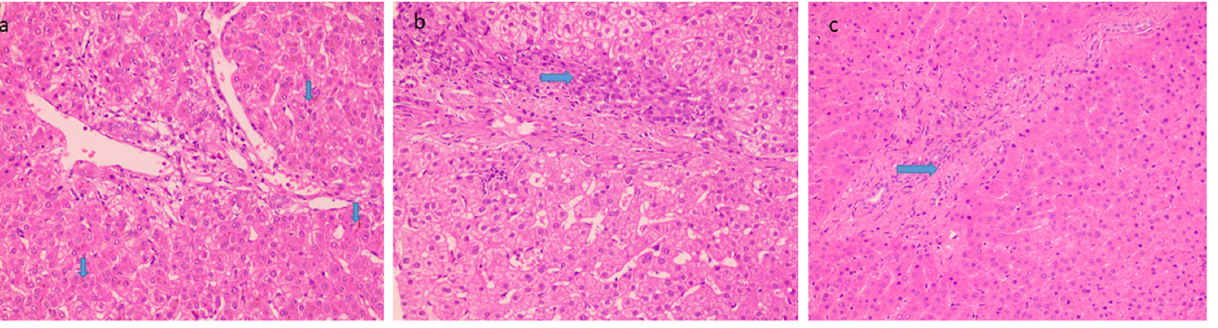
Figure 3. Histological features favoring biliopathy ( a ) bile stasis (20×, HE, arrow) ( b ) ductular reaction (20×, HE, arrow) and ( c ) increased periportal fibrosis (20×, HE, arrow).